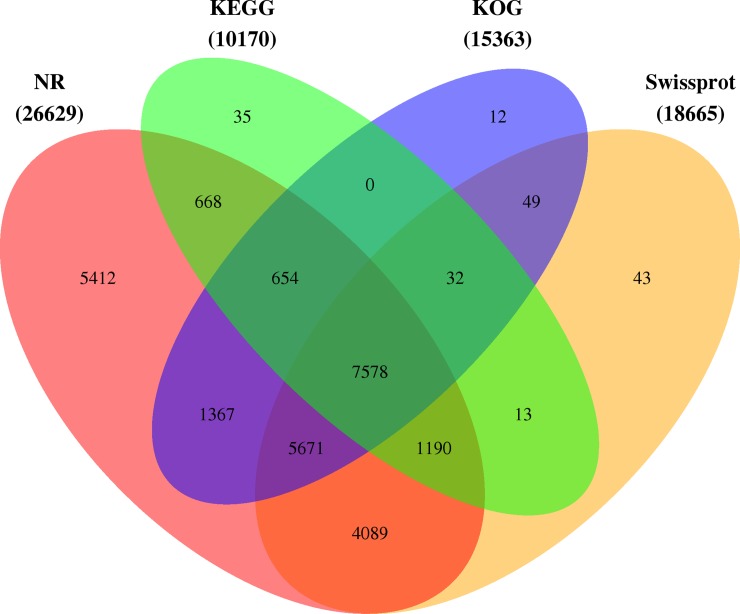
The KEGG, KOG, Nr, and Swiss-Prot database annotations of Venn diagram of expressed unigenes.The co-expressed unigenes from C. oleifera seeds in three biological repeats were annotated and incorporated by the KEGG, KOG, Nr, and Swiss-Prot databases. In total, 26,813 unigenes matched with at least one database, and 7578 shared unigenes matched with all four databases.